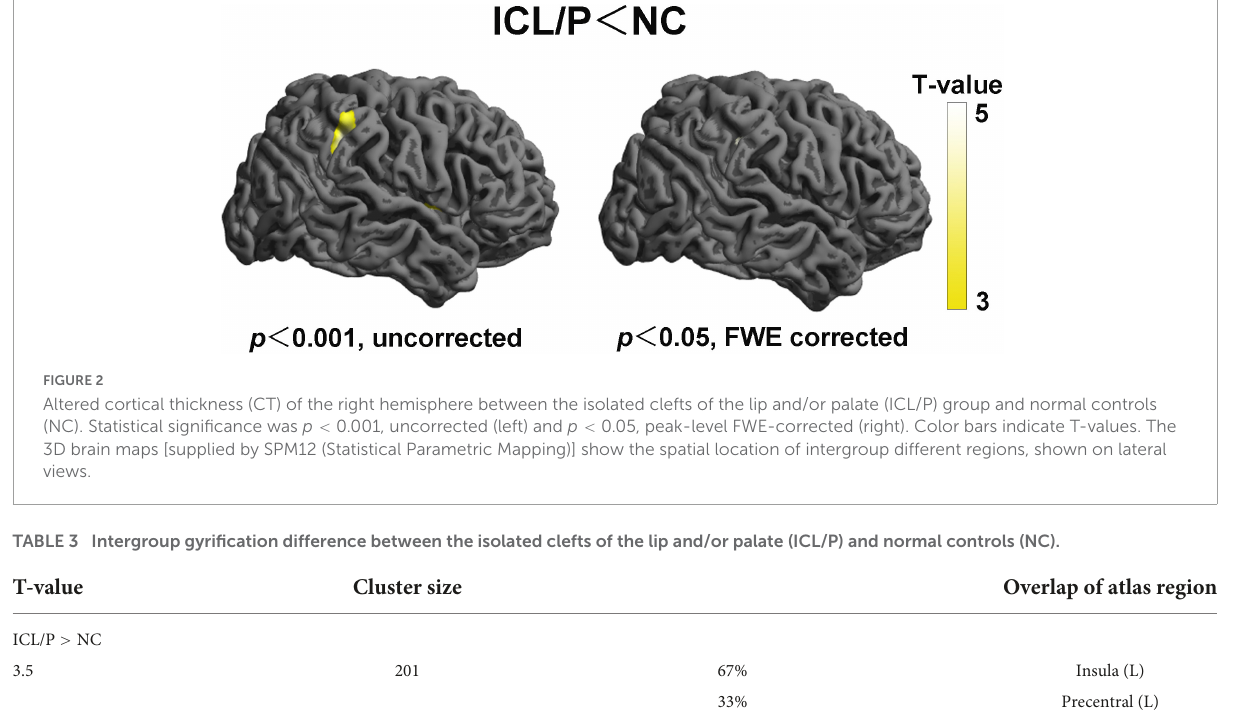
TABLE 3 Intergroup gyrification difference between the isolated clefts of the lip and/or palate (ICL/P) and normal controls (NC). T-value Cluster size Overlap of atlas region ICL/P > NC 3.5 201 67% Insula (L) 33% Precentral (L) 168 100% Middle temporal (L) 58 100% Superiotemporal